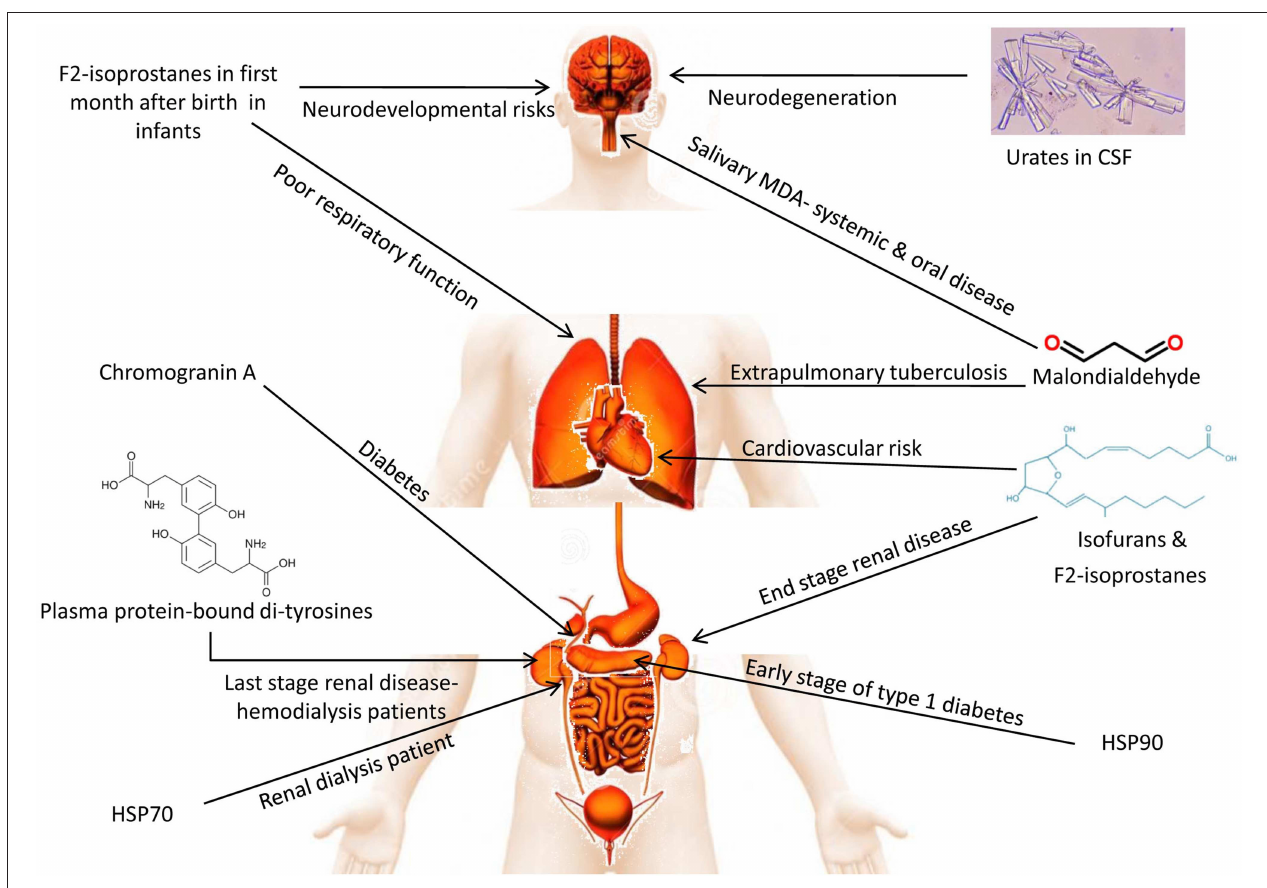
FIGURE 7 | Biomarkers in prognosis of stress related